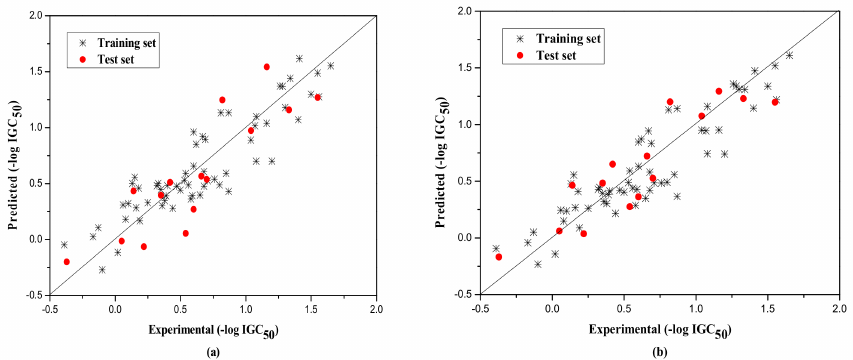
Figure 2. Plot of the predicted versus experimental − log IGC 50 including the training and the test set compounds of Group 2 by MLR model ( a ) and by RBFNN model ( b ).